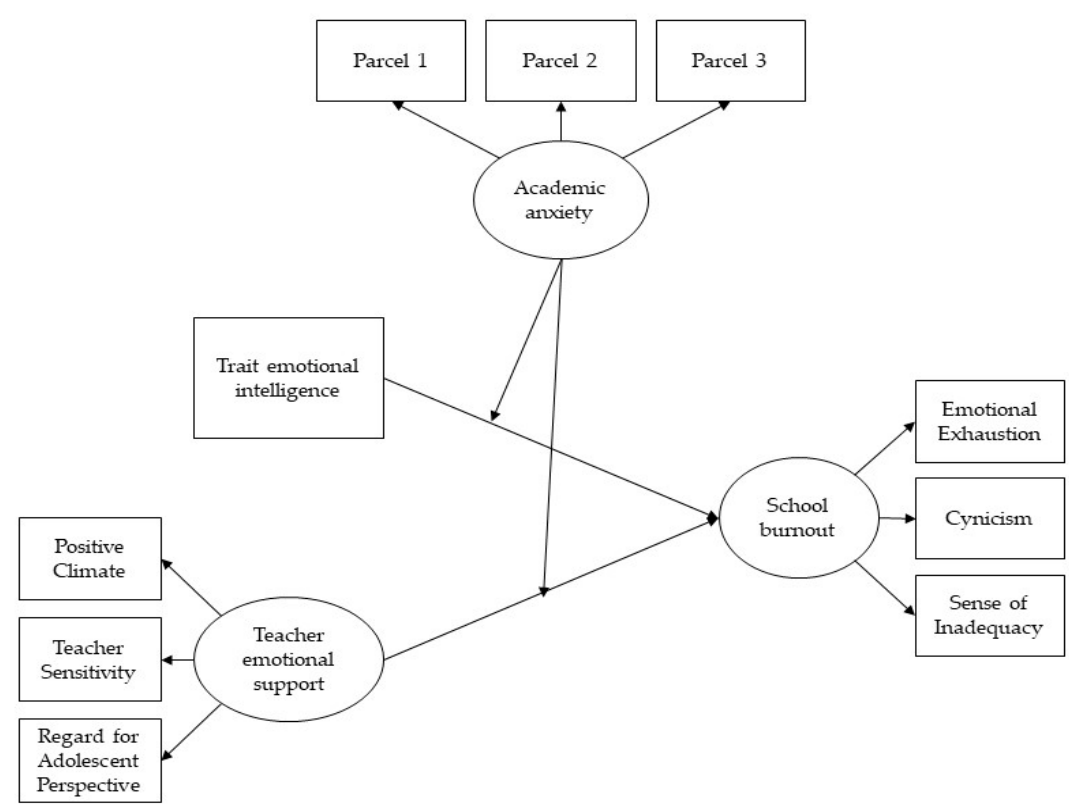
Figure 1. A conceptual model of the hypothesized moderating effect of academic anxiety on the links between trait emotional intelligence and perceived teacher emotional support with school burnout.